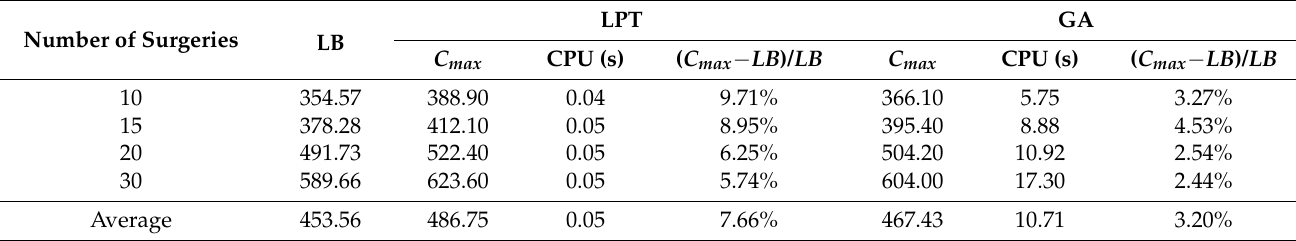
Table 9. The overall results of the